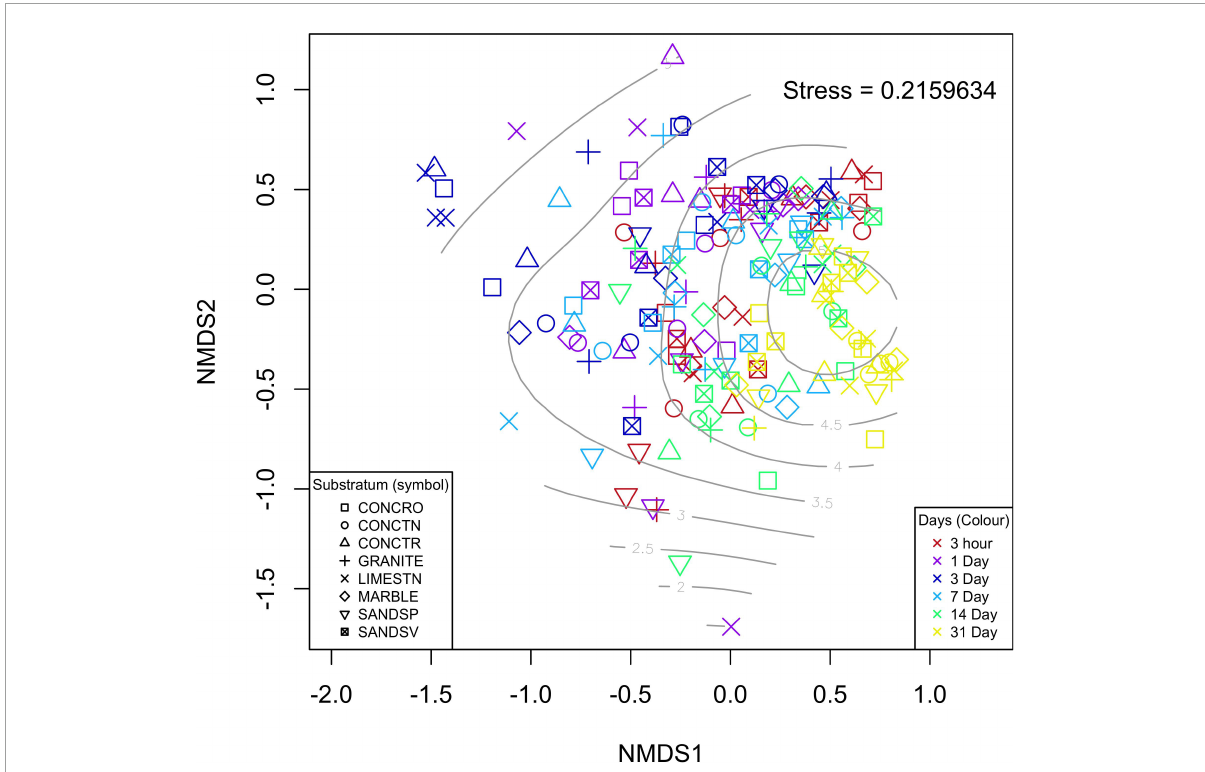
FIGURE2 nMDS ordination of the individual samples used for 16S rRNA gene SNV analyses. Each substratum is indicated by a different symbol, whereas biofilm age is represented by color of the points on the plot. Light gray contour lines are indicative of Shannon-wiener diversity indices for each